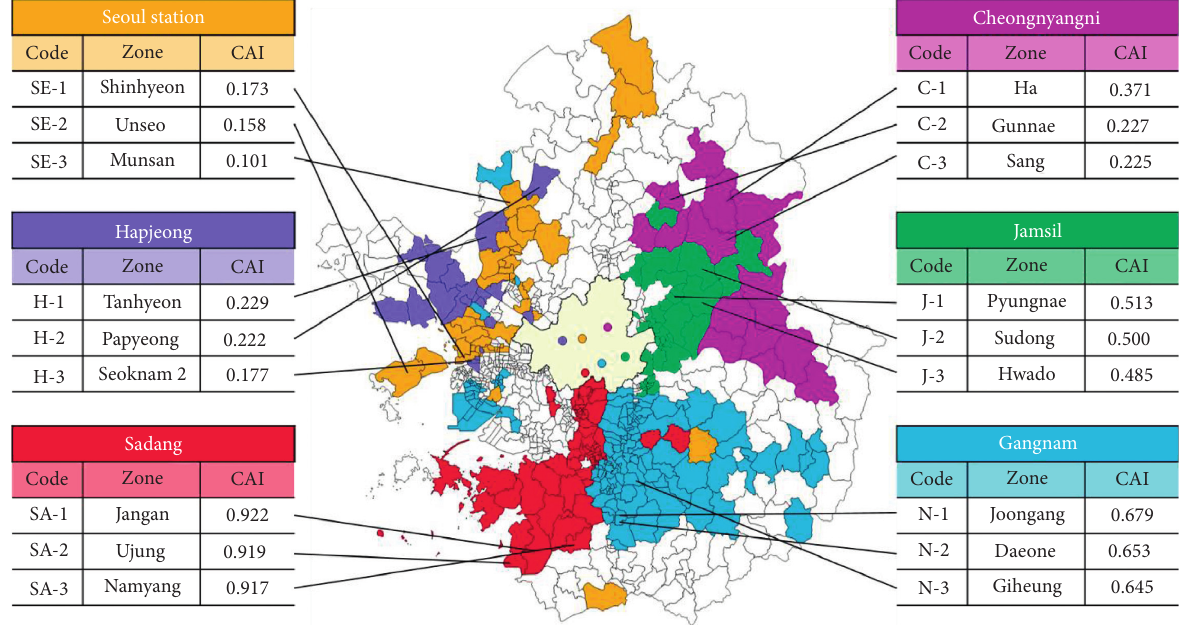
Figure 4: Areas influenced by each center and the three regions in each center that have the highest